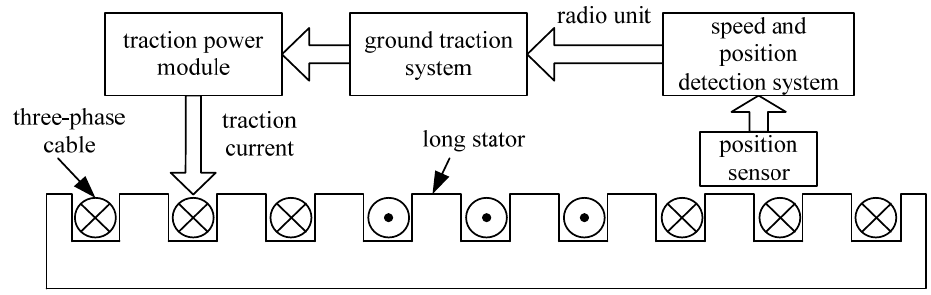
Figure 2. Composition of the synchronous traction system.